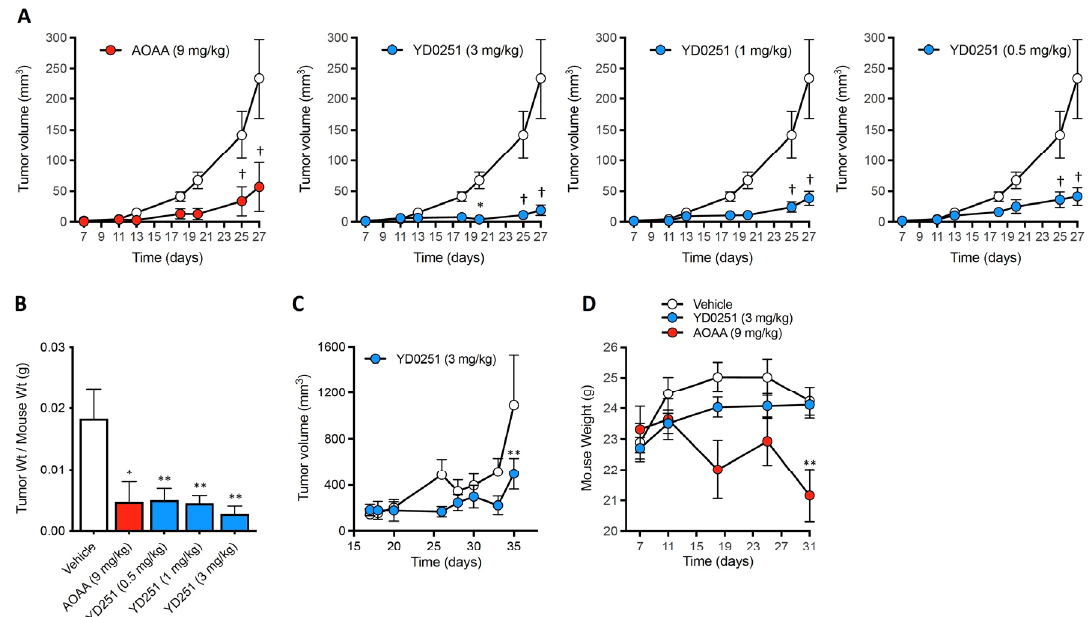
Figure 6. YD0251 is more potent than AOAA at inhibiting HCT116 tumor xenograft growth In Vivo. The compounds were administered daily at the indicated doses by subcutaneous injection ( A , B ) and oral gavage ( C ). Data are expressed as ratio of tumor weight to mouse body weight at harvest following 21 days of treatment. YD0251 did not affect the weight of the animals over the course of the experiments, while AOAA induced a significant weight loss by Day 31 ( D ). (n = 6 mice/group, * p < 0.05, † p < 0.05, ** p < 0.01).